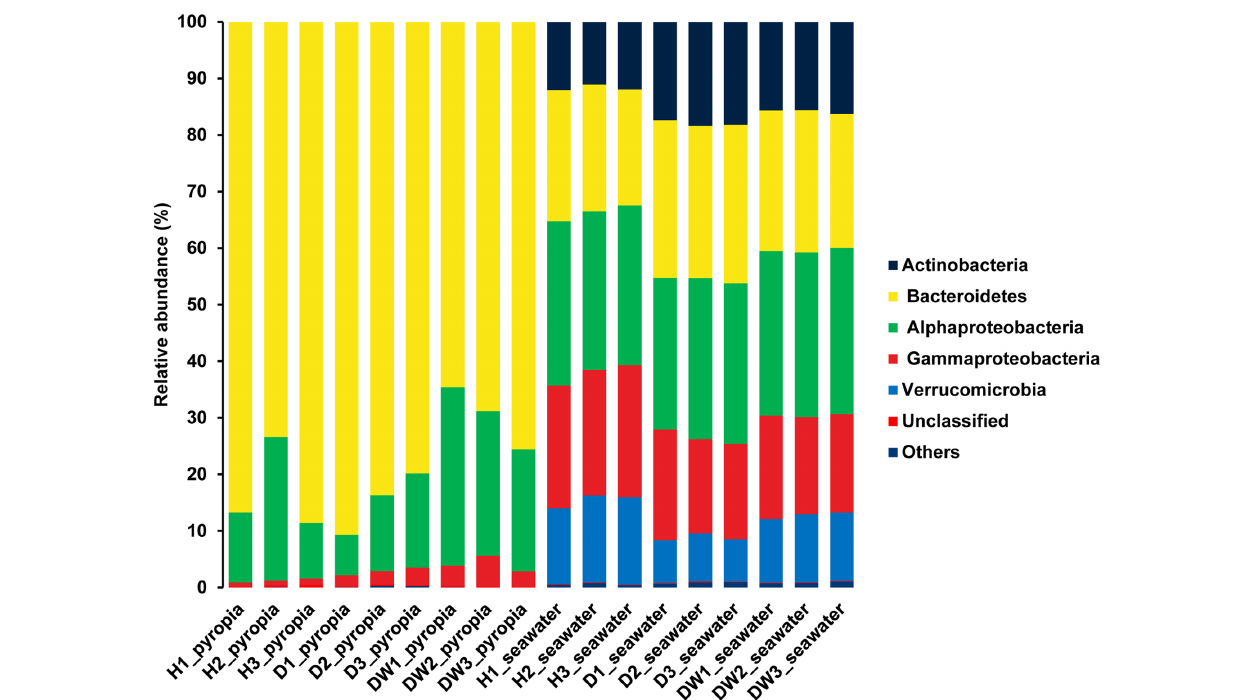
FIGURE 4 | Bacterial community structures associated with Pyropia yezoensis and seawater at the phylum/class level. H, uninfected; D, locally infected; DW, seriously infected.